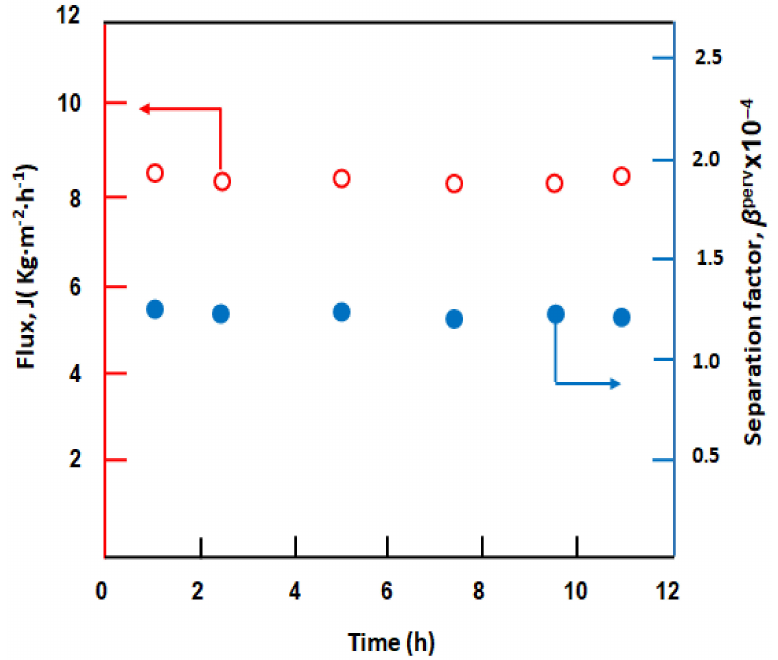
Figure 13. Variation of the cumulative total flux and the selectivity of the organic mixture extracted by the SILICONE1200-260 µ m membrane as a function of time at 20 ◦ C.